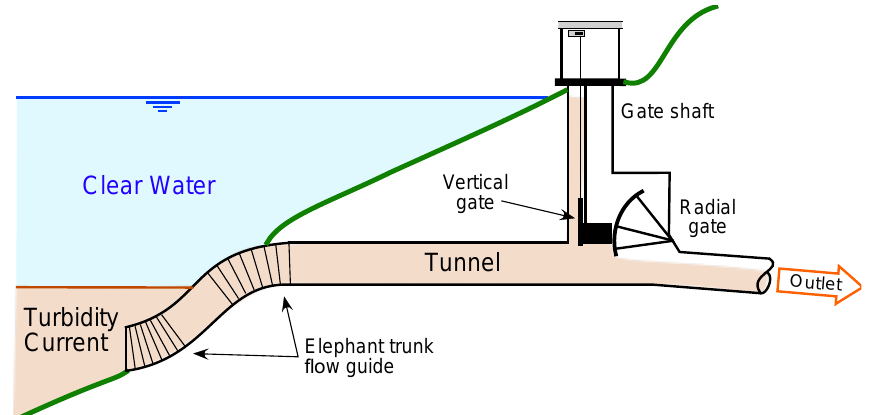
Figure 9. Aspiration of turbidity current into a higher level outlet tunnel with an “elephant trunk” flow guide—Zengwen reservoir, Taiwan (redrawn from site visit handout).